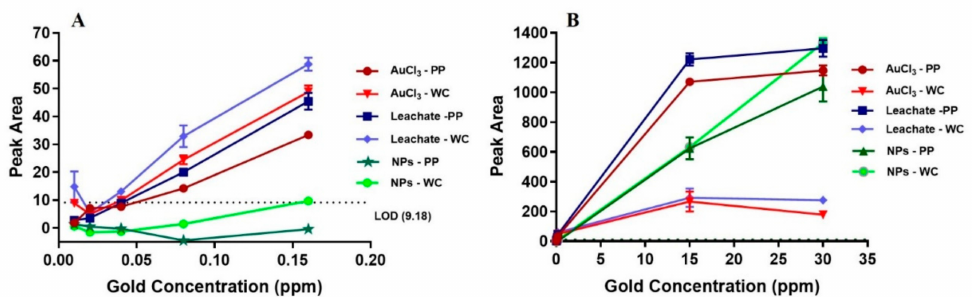
Figure 4. LIBS signal intensity of PP and WC coatings incubated with gold ion and gold NP solutions as a function of low ( A ) and high ( B ) gold concentration of the solutions. LOD is shown as dotted line.